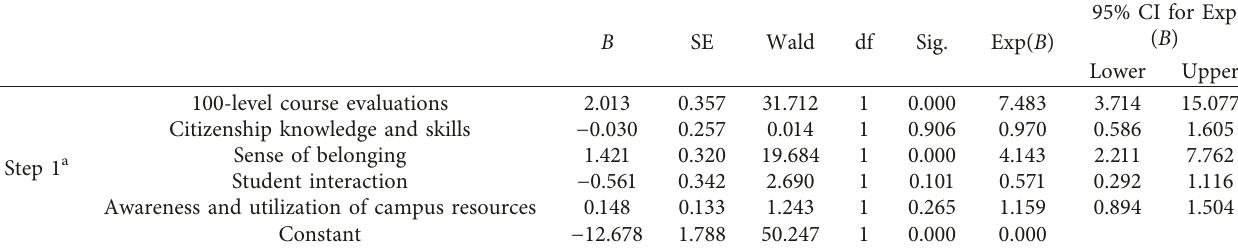
Table 11: Variables in the